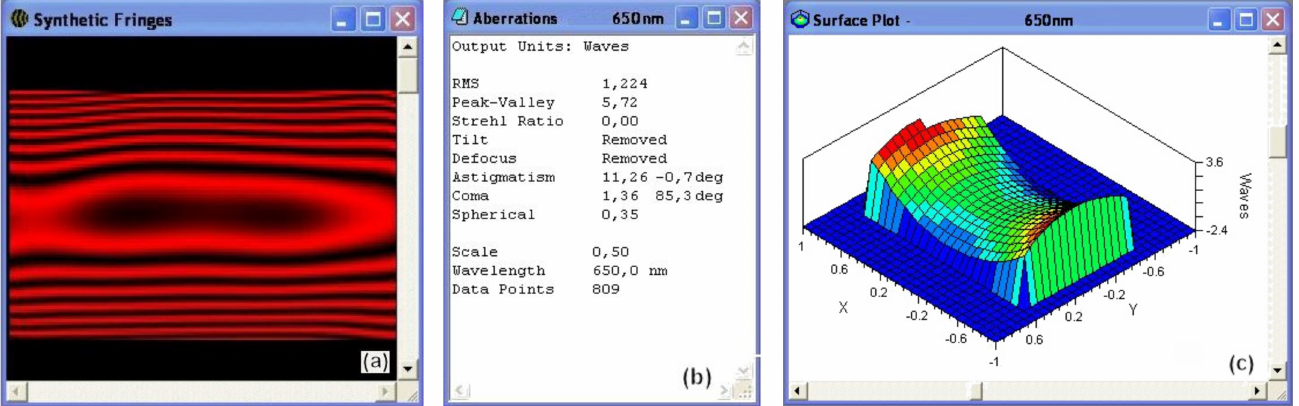
Figure 5. Synthetic fringes of the deformed matrix under test ( a ), aberration table analysis ( b ), and surface plot ( c ). The freeform matrix optical test is reduced with Quick Fringes at λ = 650 nm